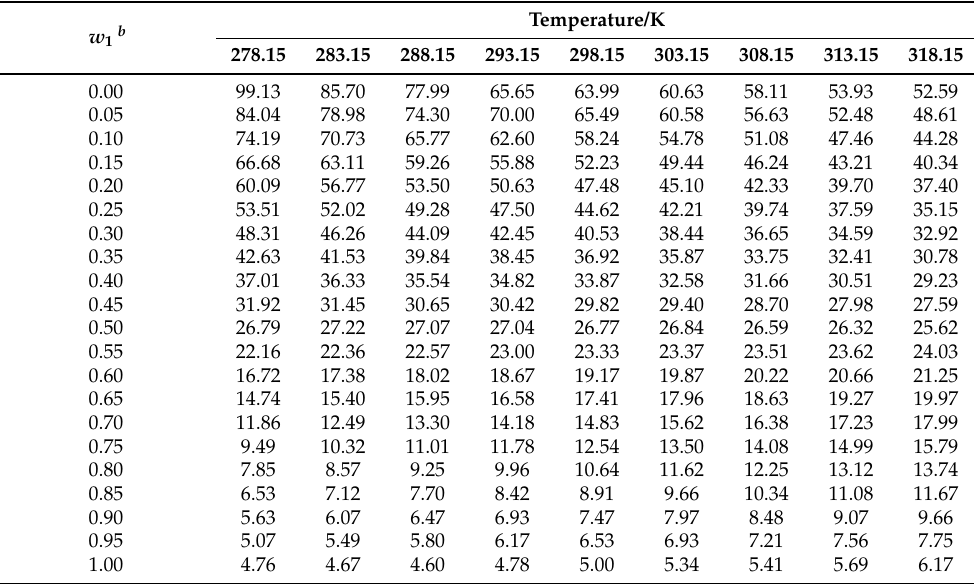
Table 4. Activity coefficient of sulfadiazine (3) in {acetonitrile (1) + 1-propanol (2)} cosolvent mixtures at different temperatures and pressure p = 0.096 MPa a